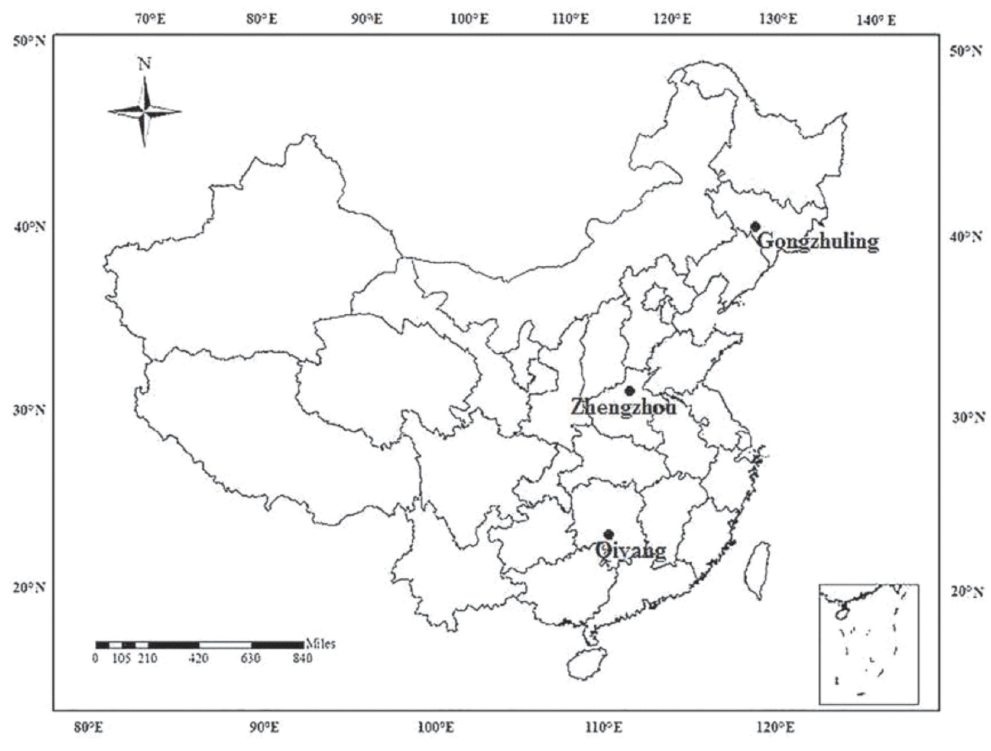
Fig 1. Locations of the three long-term fertilizer application sites in